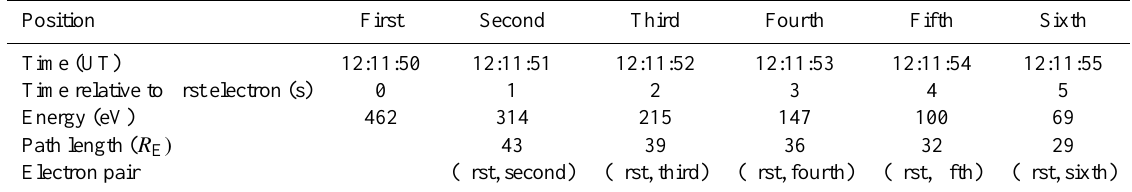
Table 1. Dispersion time, energy, and electron path lengths estimated by Eq. (4) in the model run shown in Fig. 2 (see text). The fifth row lists the electron path lengths calculated from the given electron